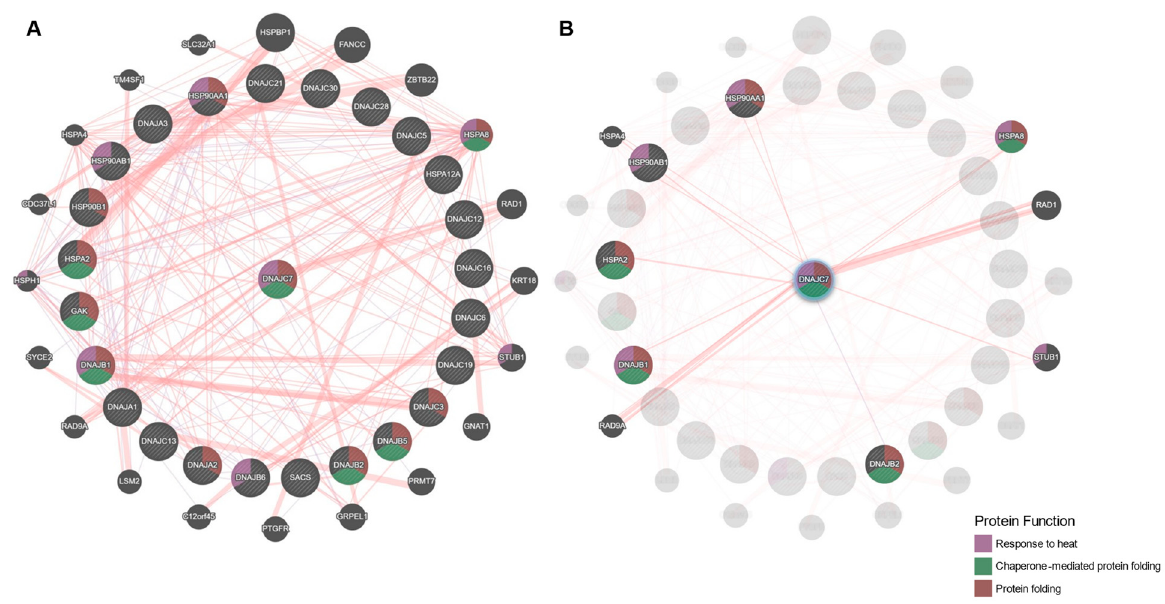
Figure 4. Map of known physical interactions between a selection of J proteins, Hsp70s, Hsp90s, and other relevant co-factors. The interaction map was created using the GeneMANIA prediction server (https://genemania.org/ accessed on 12 March 2022) [67] by inputting a selection of 20 J proteins, two Hsp70s, and three Hsp90s. Using this selection, the prediction server was then able to select other relevant interactors: ( A ) all physical interactions between the J proteins, Hsp70s, Hsp90s, and other relevant cofactors; ( B ) proteins known to physically interact with DnaJC7.